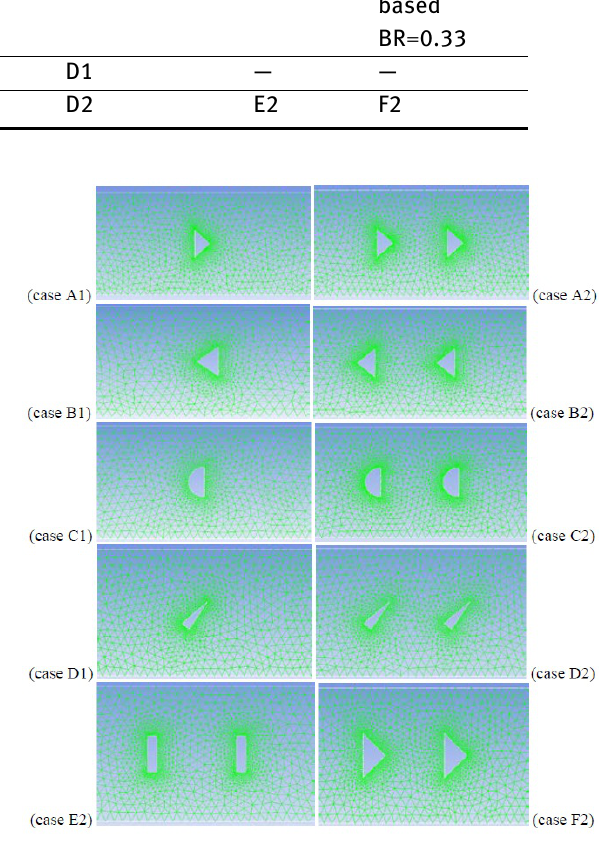
Figure 3: Focused view of the grid in the vicinity of the bluff